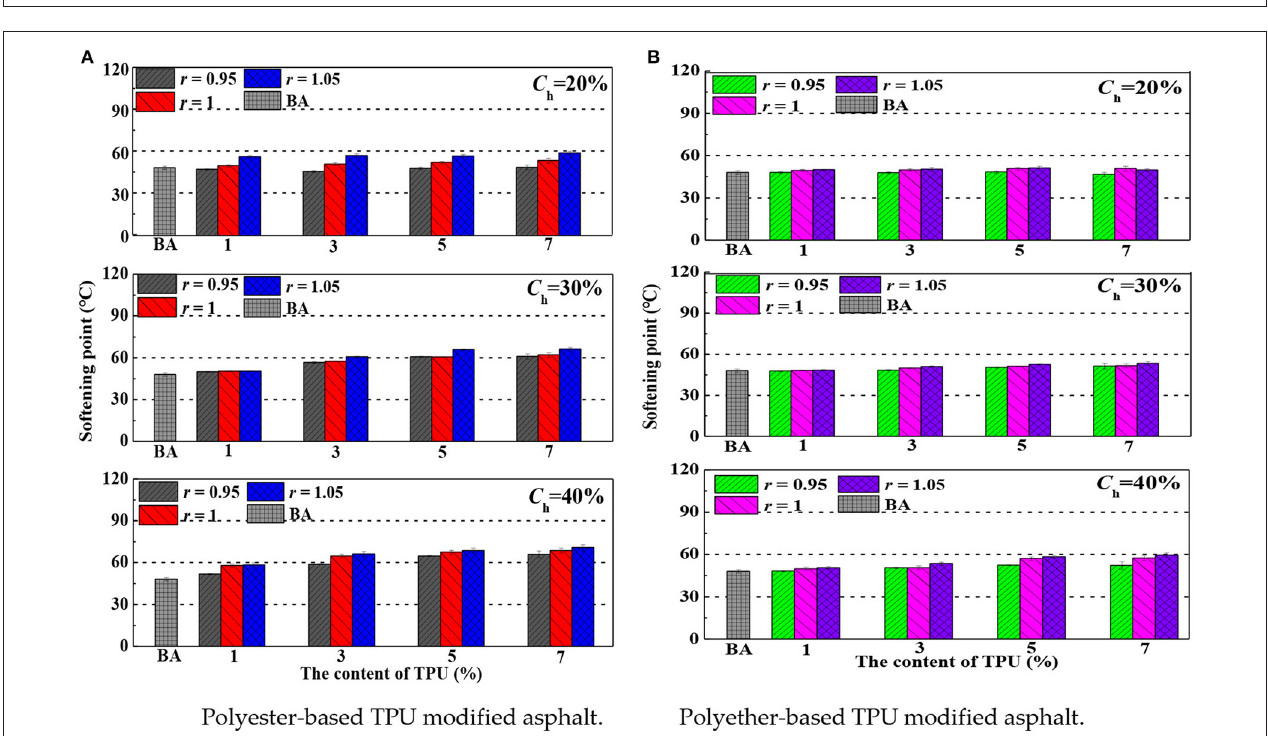
FIGURE 10A | The softening point of modified asphalt. (A) Polyester-based TPU-modified asphalt. (B) Polyether-based TPU-modified asphalt.